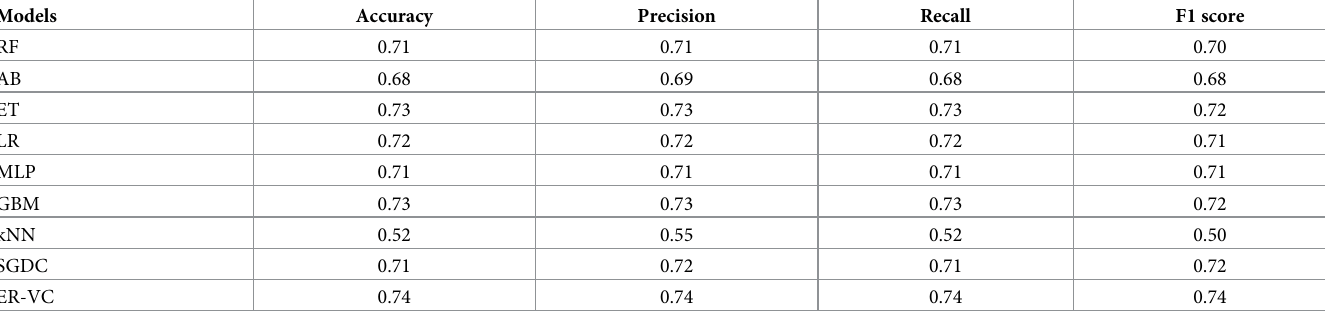
Table 4. Classification results of machine learning models using BoW on imbalanced dataset.